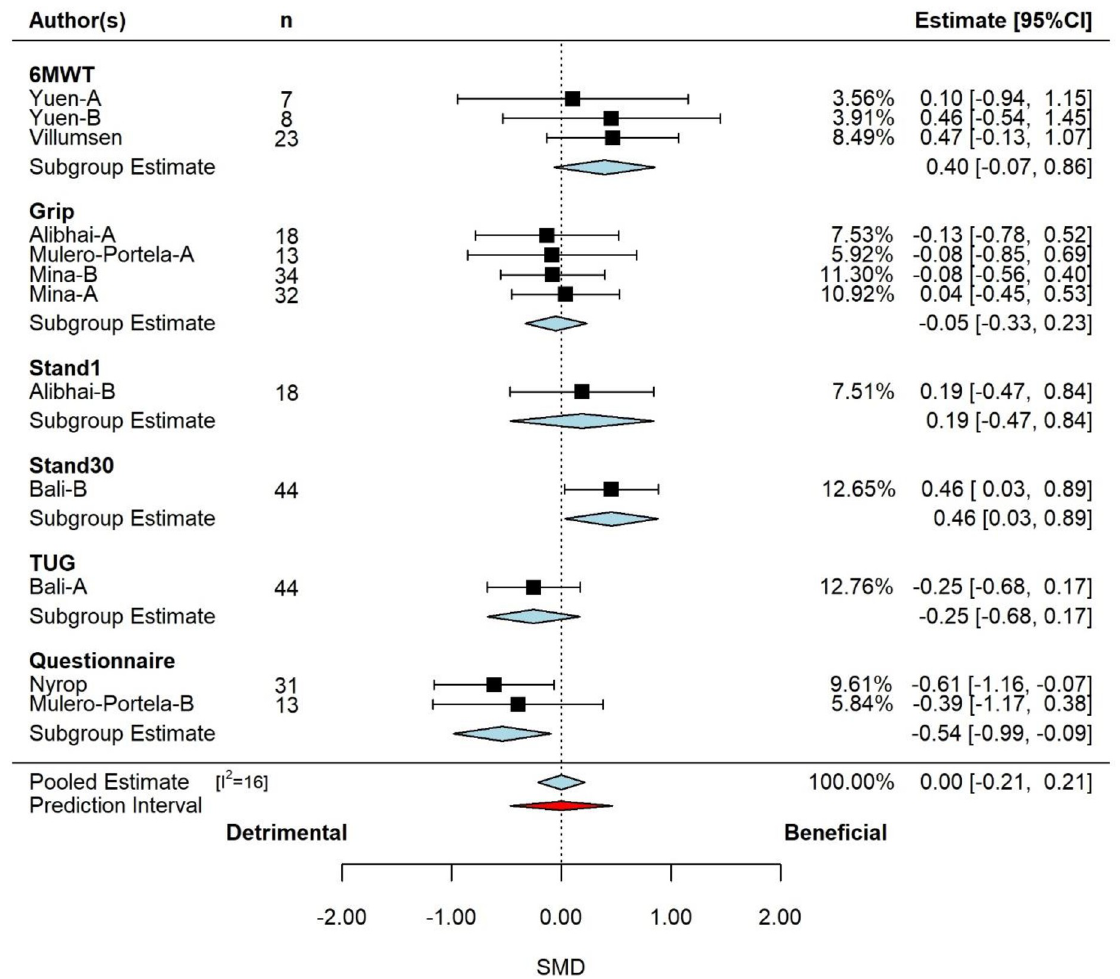
Fig 5. Pooled effect of exercise intervention on physical function, with sub-group analysis by assessment type (k = 10, u = 14, n = 508). Based on the 3-level model, there was no discernable effect (SMD = 0.00, 95% CI: -0.21 to 0.21, p = 1.000). Abbreviations : CI, confidence interval; SMD, standardized mean